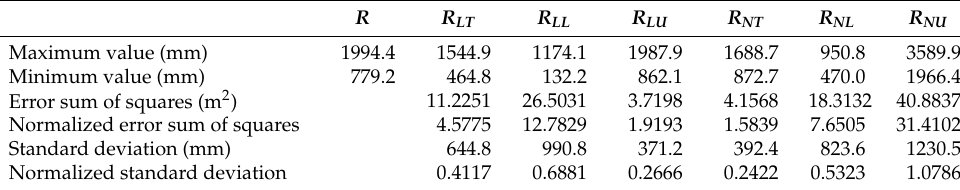
Table 9. Statistics of rainfall predictions for 79 occurrence-time-unknown LSL cases.